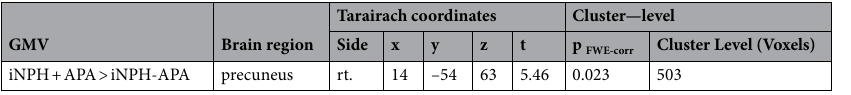
Table 2. MNI coordinates of the brain regions with significant differences in rGMV between the two groups. GMV, Gray matter volume; iNPH, Idiopathic normal pressure hydrocephalus; APA, Apathy; FEW-corr, Family wise error-corrected; rt., right.